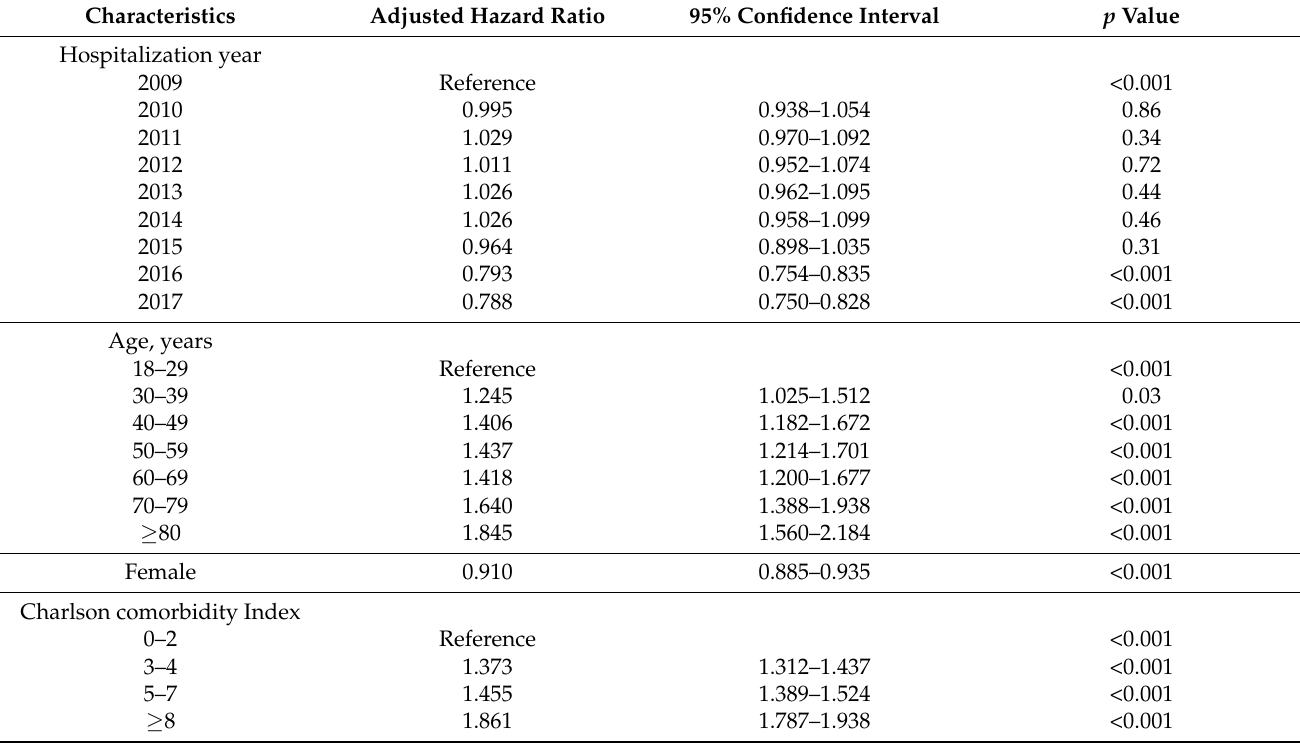
Table 2. Impact of hospitalization year among the cancer patients with septic shock on the 30-day mortality, adjusted for age, sex, and Charlson comorbidity index using multivariate Cox-proportional hazard analysis. Characteristics